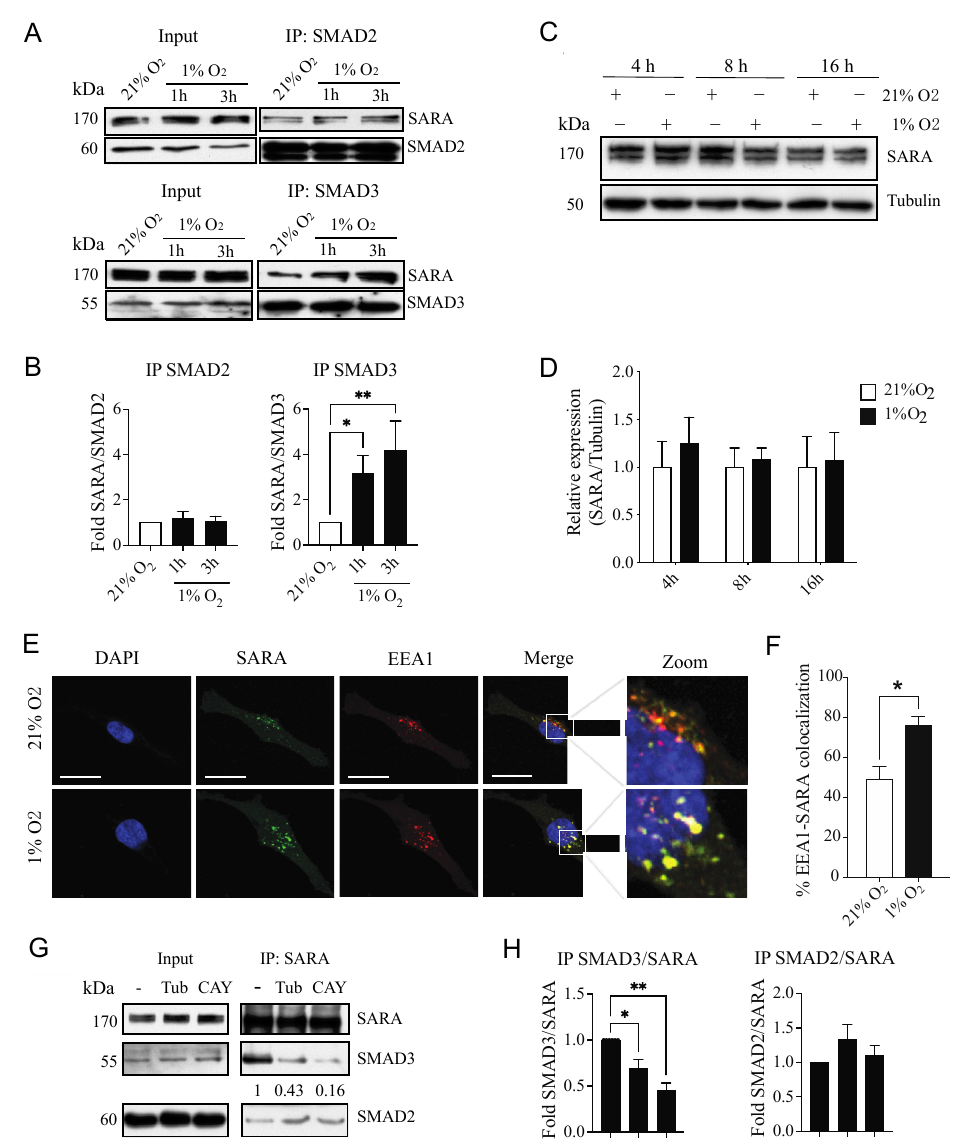
Figure 6. Effect of Hypoxia and HDAC6 Activity on SMAD3/SARA Interaction. ( A , B ) Co-immunoprecipitation of SMAD2 or SMAD3 from HT-1080 cells incubated under normoxic (21% O 2 ) or hypoxic (1% O 2 ) condition. Representative Western blot images ( A ) and densitometric analysis ( B ) are presented ( n = 4–5). ( C , D ) HT-1080 cell-derived proteins were extracted after increasing incubation period under hypoxic conditions, then immunoblotted for SARA and tubulin, as loading control. Representative western Blot images ( C ) and densitometric quantitation of relative SARA protein expression ( D ) are presented ( n = 3). Data are presented as mean ± SEM. * p > 0.05; ** p < 0.01. ( E , F ) Immunofluorescence assay of HT-1080 cells stained for DAPI (nucleus; blue), SARA (green) and EEA1 (red). Representative confocal images ( E ) and quantitation of SARA/EEA1 colocalization ( F ) are presented ( n = 3, >10 cells per experiment). Data are presented as mean ± SEM. * p > 0.05. ( G , H ) HT-1080 cells were treated with the HDAC6 inhibitors tubacin or CAY10603, then incubated for 3 h under hypoxic conditions. ( G ) Representative co-immunoprecipitation of SARA, immunoblot- ted for SARA, SMAD3 and SMAD2, in hypoxic conditions (1% O 2 ) in the presence or absence of Tubacin (Tub; 10 µ M) or CAY10603 (CAY; 1 µ M). ( H ) Densitometric analysis of co-IP SMAD2 or SMAD3/SARA IP was performed ( n = 6). Data are presented as mean ± SEM. * p > 0.05; ** p <